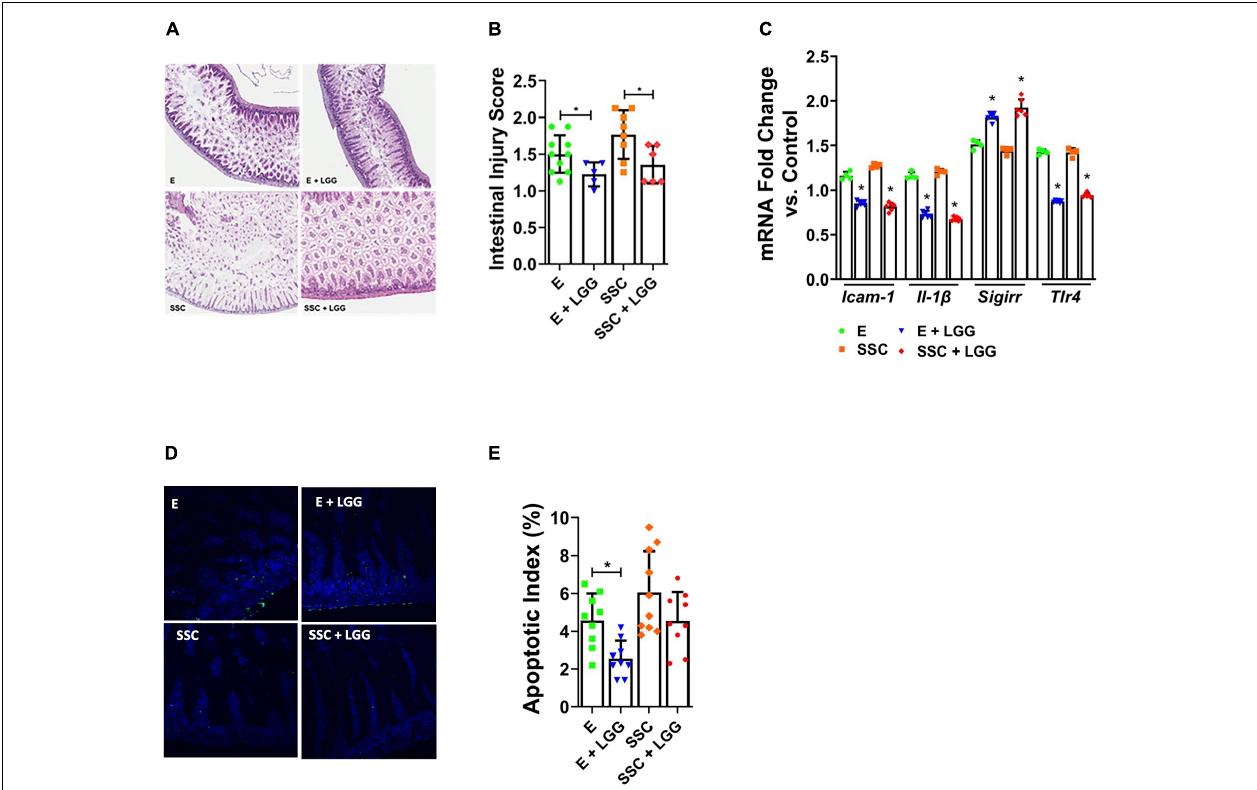
FIGURE 3 | Lactobacillus rhamnosus GG (LGG) ameliorates intestinal injury by preterm formulas. (A) Representative histologic slides of the terminal ileum of formula-fed pups with and without pre-treatment with LGG. (B) Histologic intestinal injury scores by blinded investigators. (C) Relative gene expression of ICAM1, IL-1 β , SIGIRR, and TLR4. (D) TUNEL staining of terminal ileum comparing formula versus formula + LGG. (E) Quantification of apoptosis by calculating apoptotic index (ratio of TUNEL positive cells to DAPI cells). Data presented as mean ± SD; * P < 0.05, by t -test. n = 6 pups in each group.